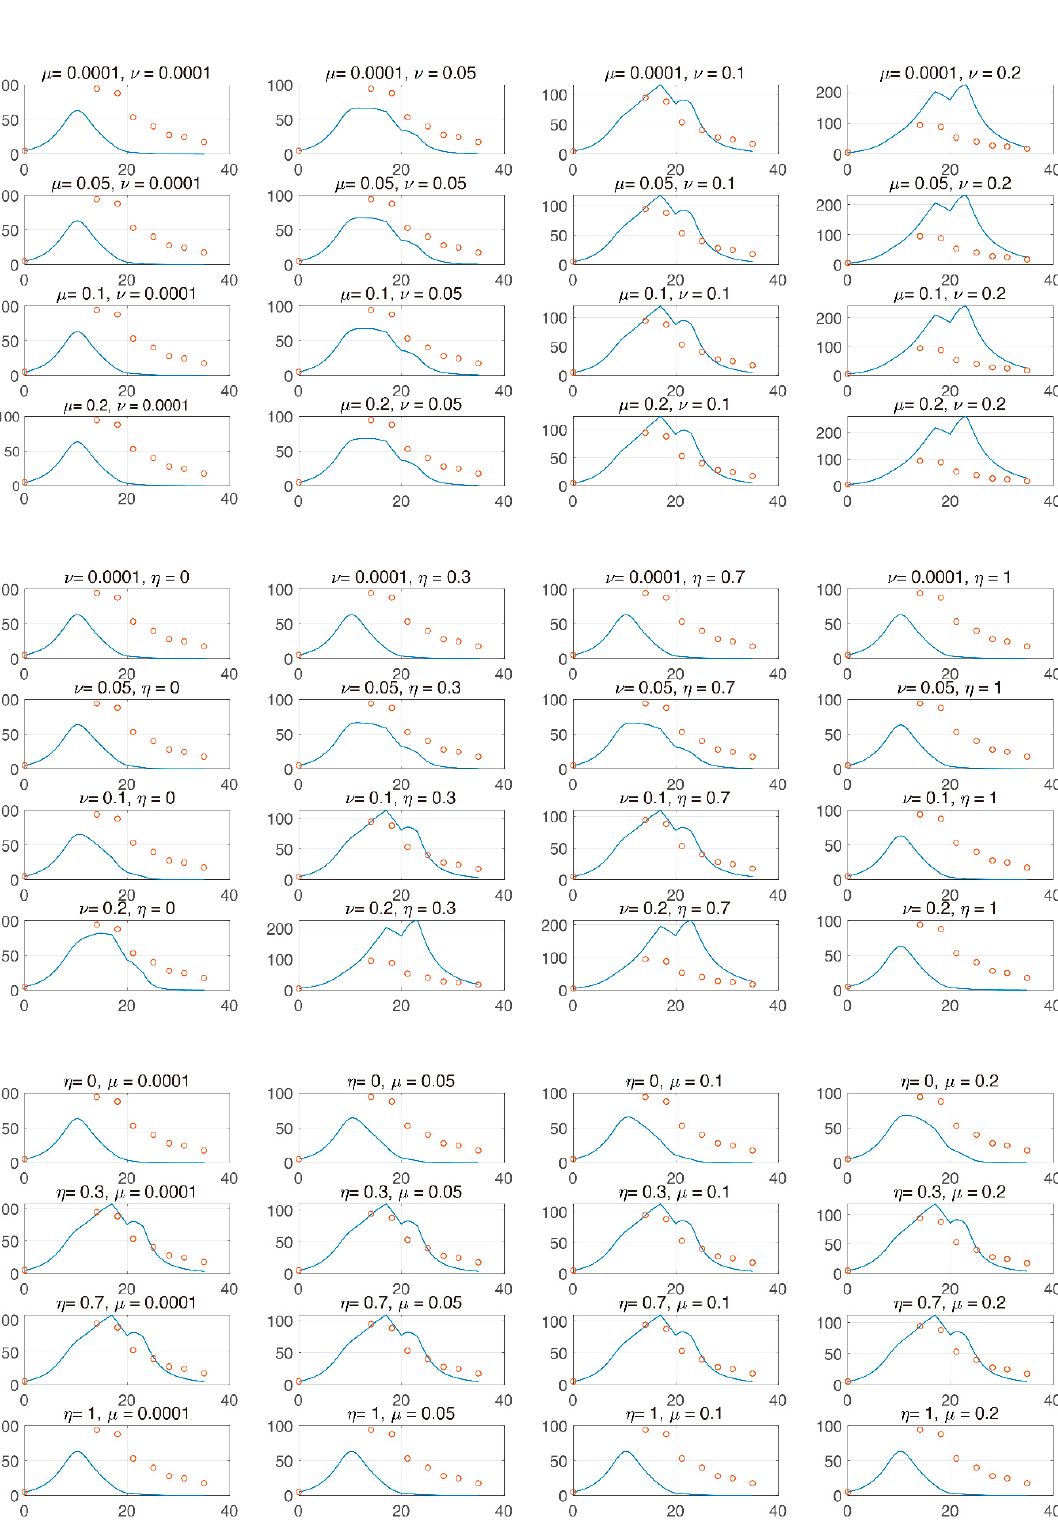
Figure 3. The x and y axes represent day and tumor size, respectively. Top panel: µ and ν are varied from [1 × 10 − 4 , 0.2] and [1 × 10 − 4 , 0.2], respectively. Center panel: µ and η are varied from [1 × 10 − 4 , 0.2] and [0, 1], respectively. Bottom panel: η and µ are varied from [0, 1] and [1 × 10 − 4 , 0.2], respectively. From these local changes, each parameter positively or negatively influences the change in tumor.